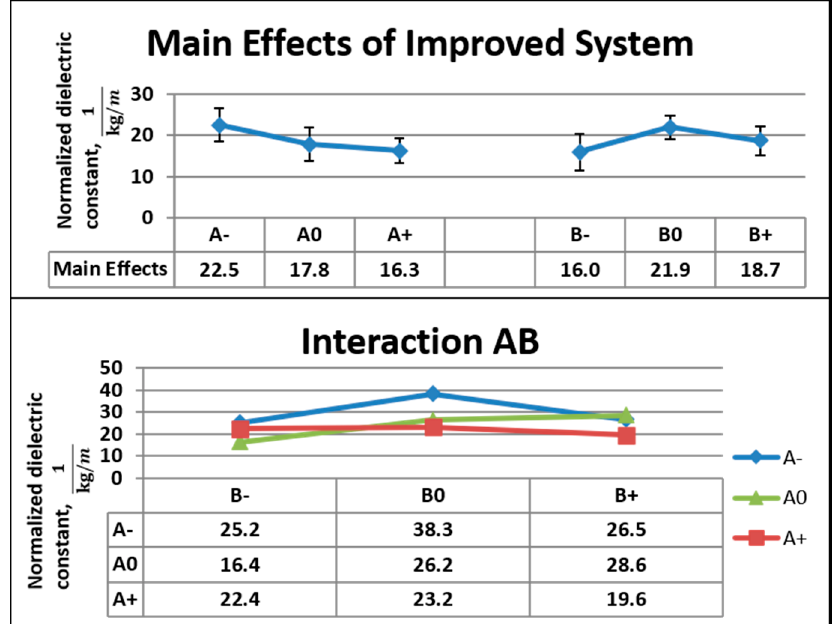
Figure 11. Main e ff ects, standard deviation, and interactions for the dielectric data of the Figure 11. Main effects, standard deviation, and interactions for the dielectric data of the improved improved system.